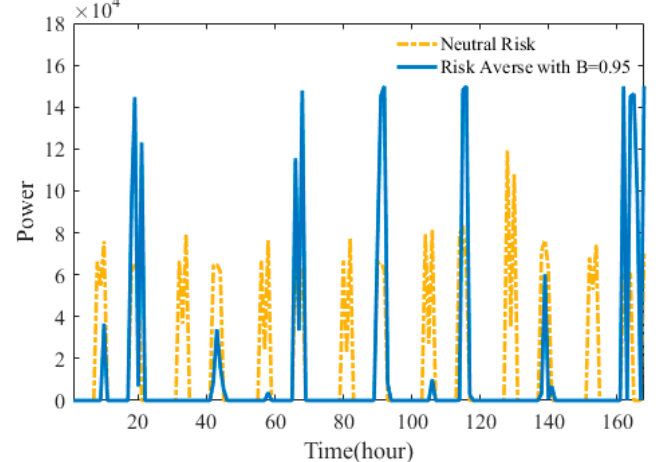
Figure 12. Transferred power from the storage to the demand side.